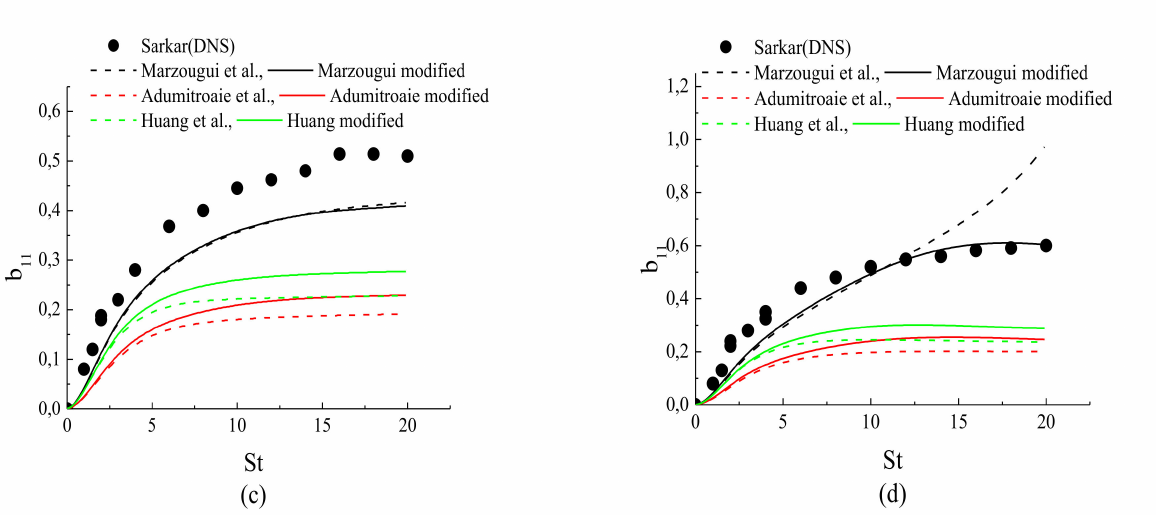
Figure 3. Time evolution of the streamwise Reynolds stress anisotropy, in the following cases: ( a ) 1;